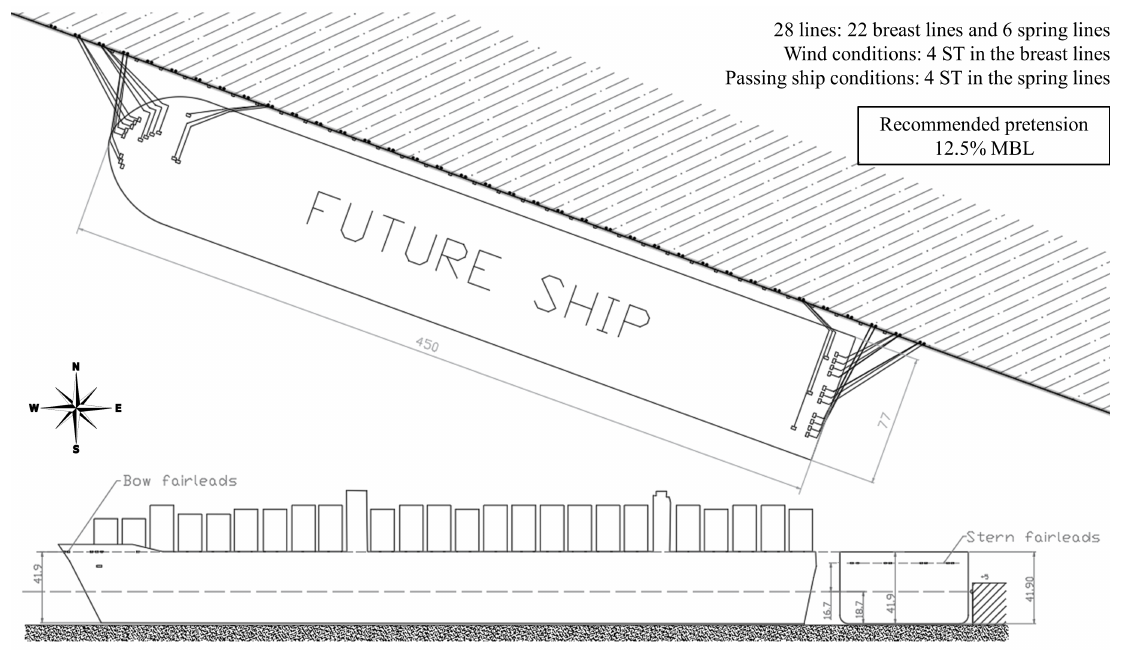
Figure 4. Future vessel selected mooring arrangement. Dimensions in m.